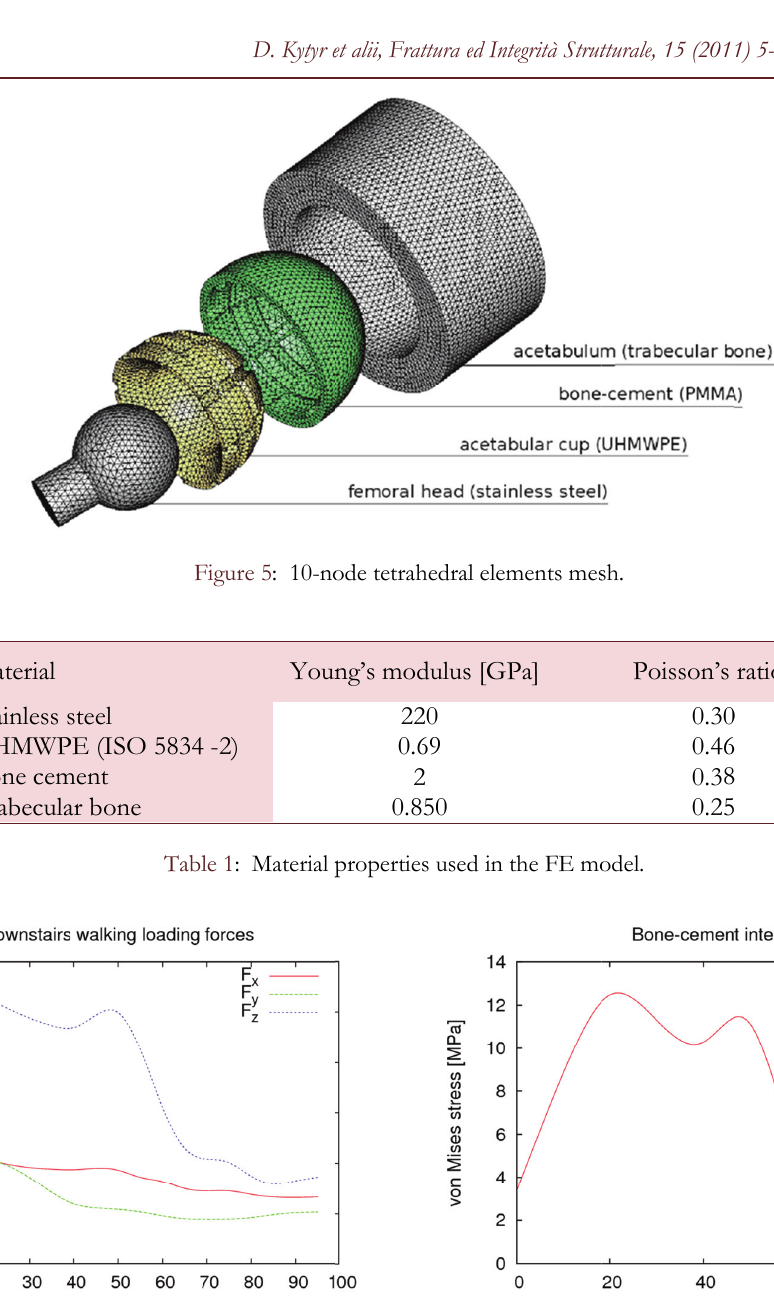
Figure 6: he stress field aximum stress erface are sh ad steps consi icrotomography